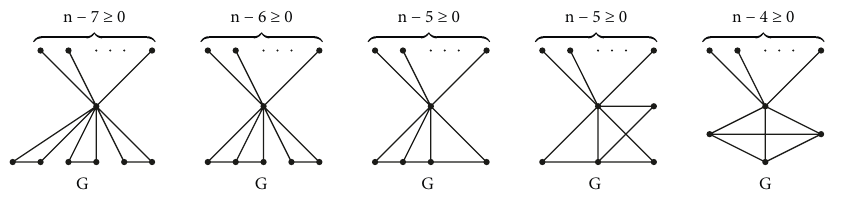
Figure 1: All possible tricyclic graphs of order n and maximum degree n −